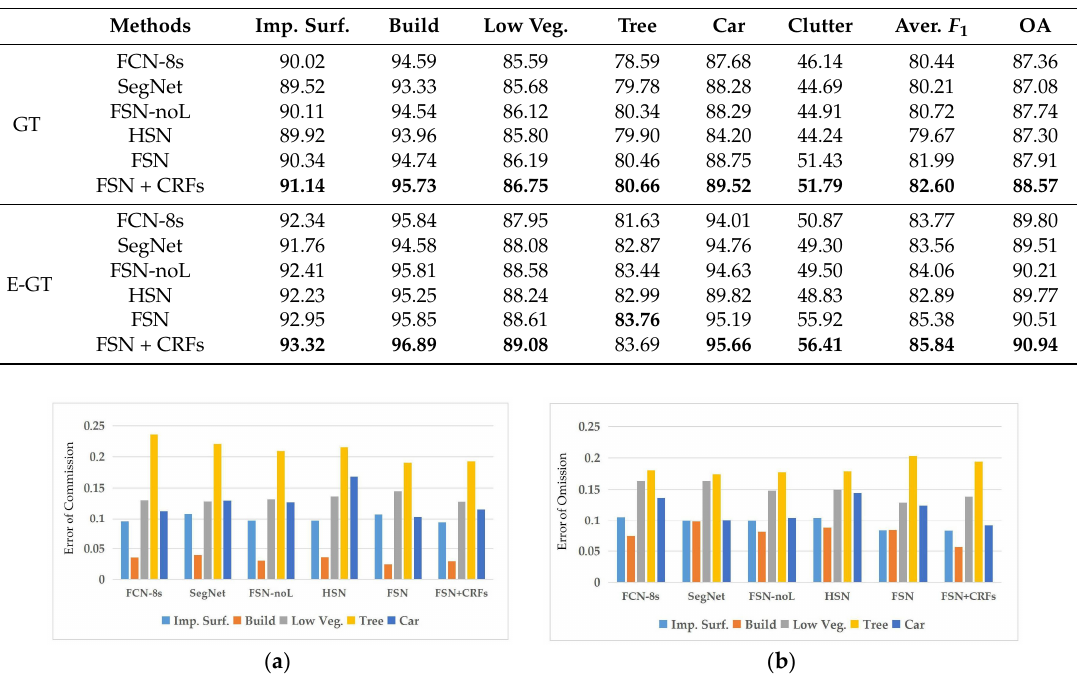
Figure 9. Errors of commission and omission of each model per classes (Potsdam dataset): ( a ) error of commission; and ( b ) error of omission. Lower values indicate the better segmentation performance. Table 6. Experimental results on Potsdam test set.